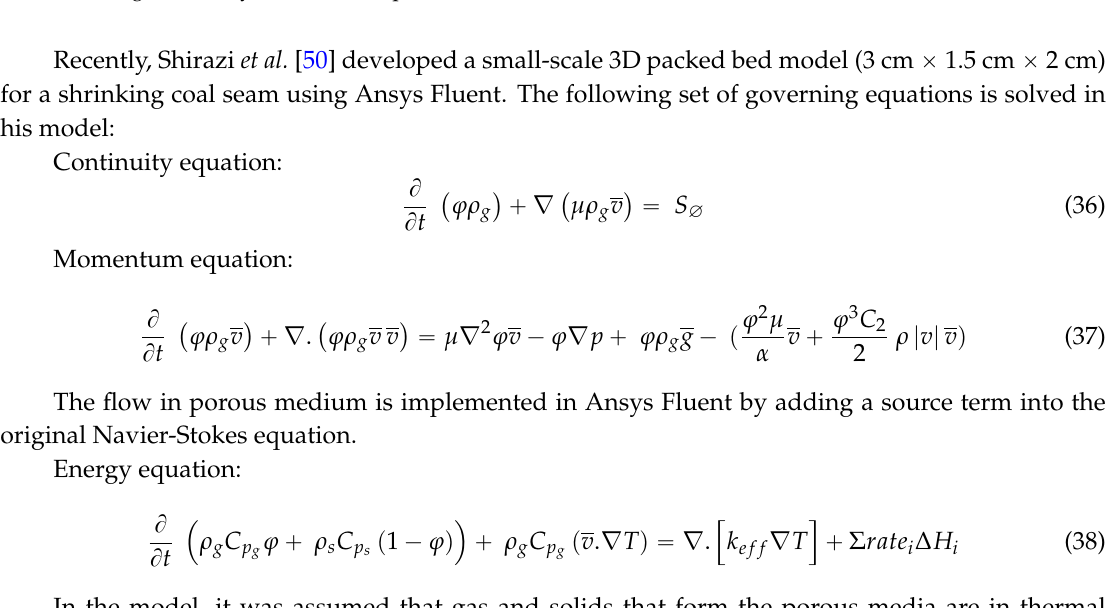
Figure 49. Cavity shape corresponding to the geological structure after 10 days of simulation: x-z cross (right) and x-y cross (left) (reproduced from Nourozieh et al. [12]).